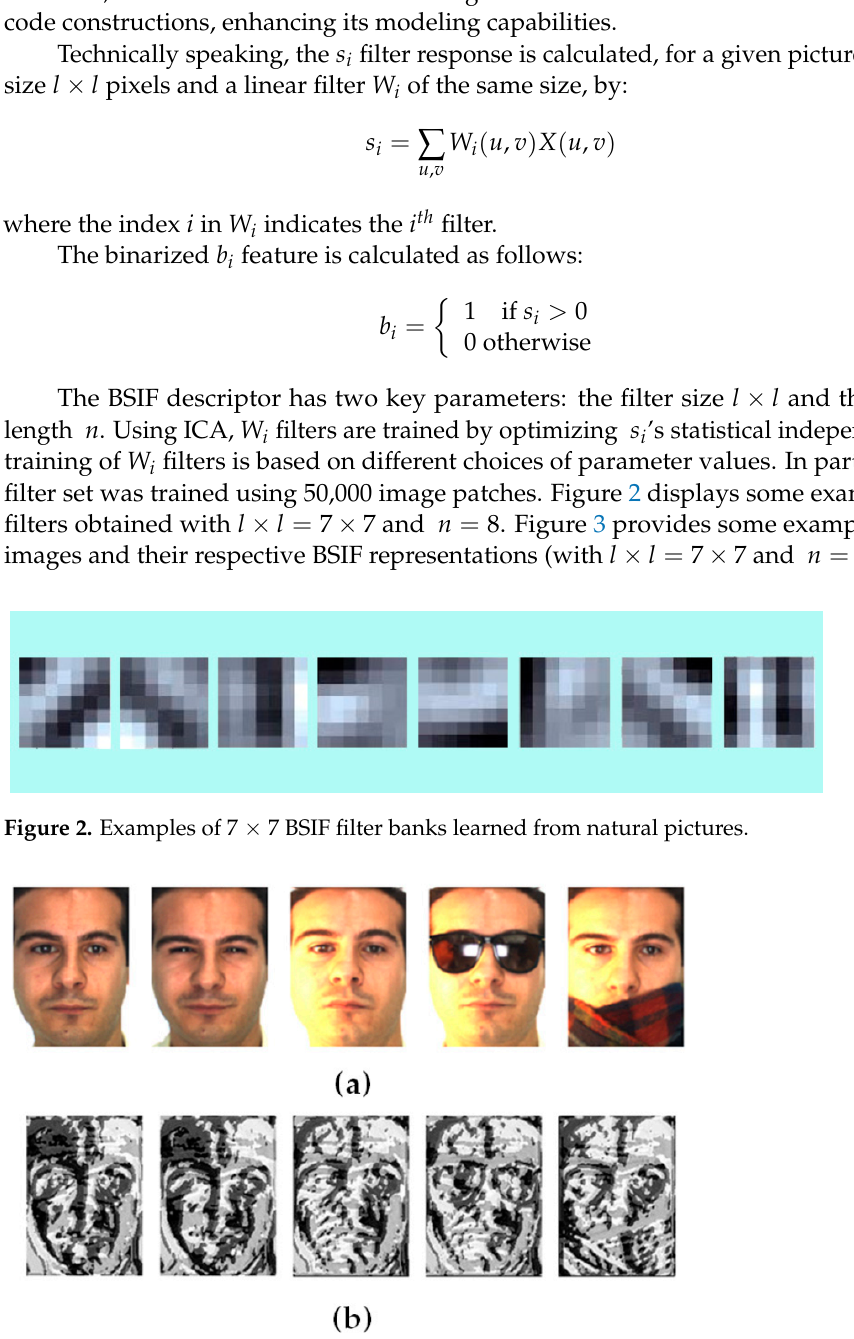
Figure 3. ( a ) Examples of facial images, and ( b ) their parallel BSIF representations. Like LBP and LPQ methodologies, the BSIF codes’ co-occurrences are collected in a histogram H 1, which is employed as a feature